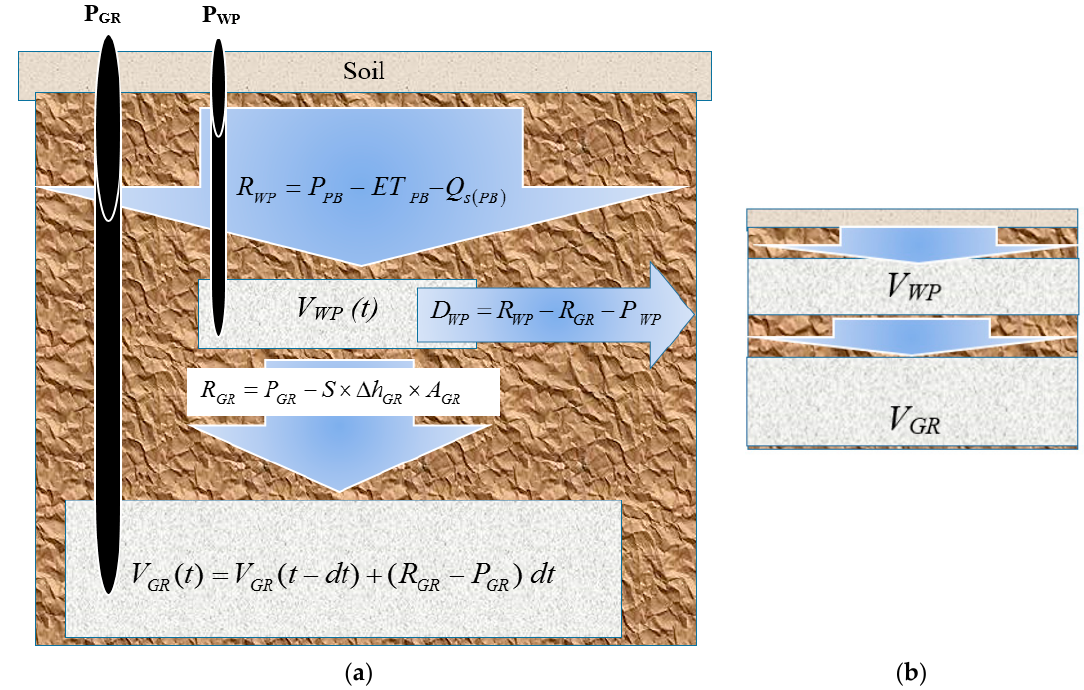
Figure 2. ( a ) Conceptual schematic of the Palouse Basin Watershed, water-balance based on the variable surface areas and pumping entities (left) ( b ) Water balance based on the surface area identical to the Palouse Basin (right).